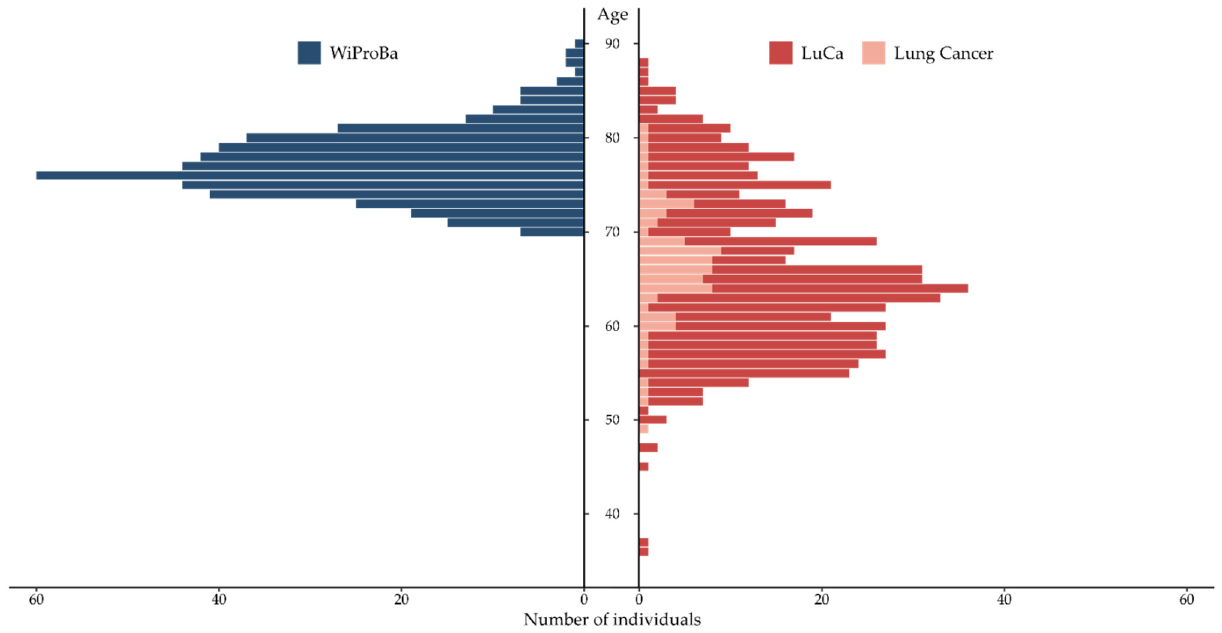
Figure 2. Age structure of the three subgroups: WiProBa (blue), LuCa (red) and lung cancer (light red).